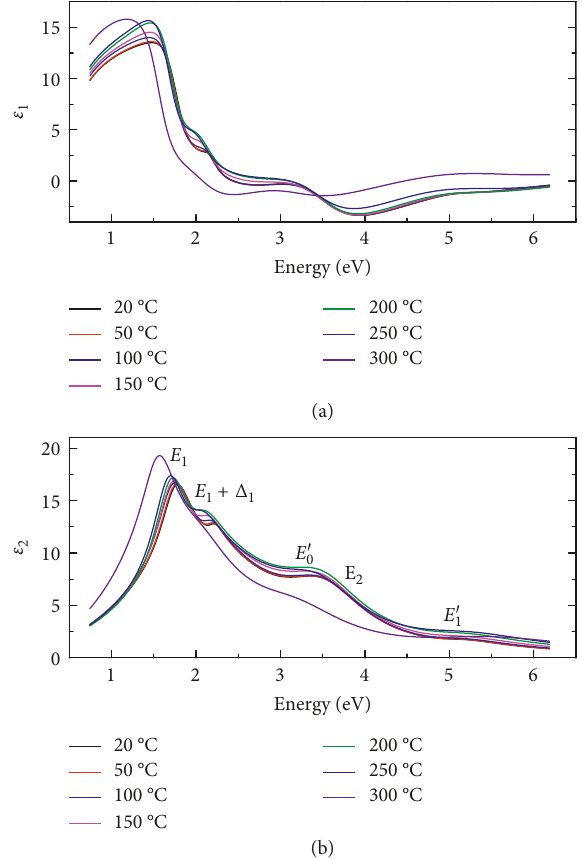
Figure 10: The real and imaginary part of the dielectric func- tion ε of the InSb thin film (S2) at varied temperatures of 20 ° C–300 °